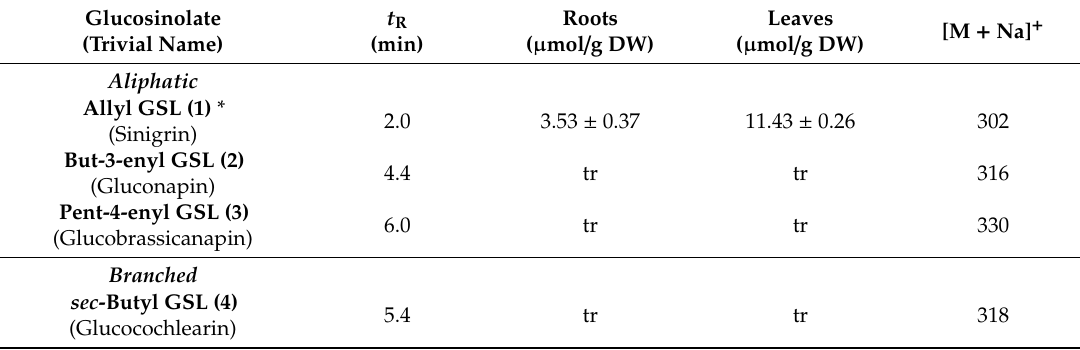
Table 1. Content of glucosinolates ( µ mol / g DW) in the roots and the leaves of horseradish.